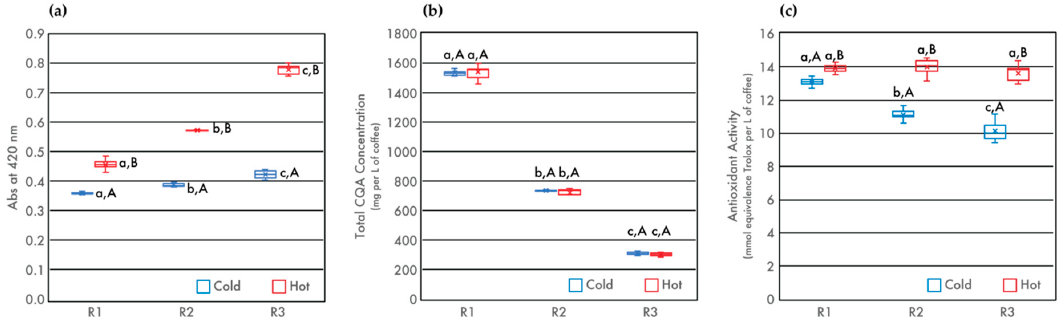
Figure 2. Absorbance at 420 nm ( a ), total CQA concentration ( b ), and total antioxidant capacity (TAC) ( c ) of cold and hot brew coffee as a function of degree of roast. Letters a–c denote significant ( p < 0.05) differences among degrees of roast within the same brewing method as determined by the Tukey HDS post-tests. Letters A and B denote significant differences between cold and hot brewing methods at the same degree of roast.